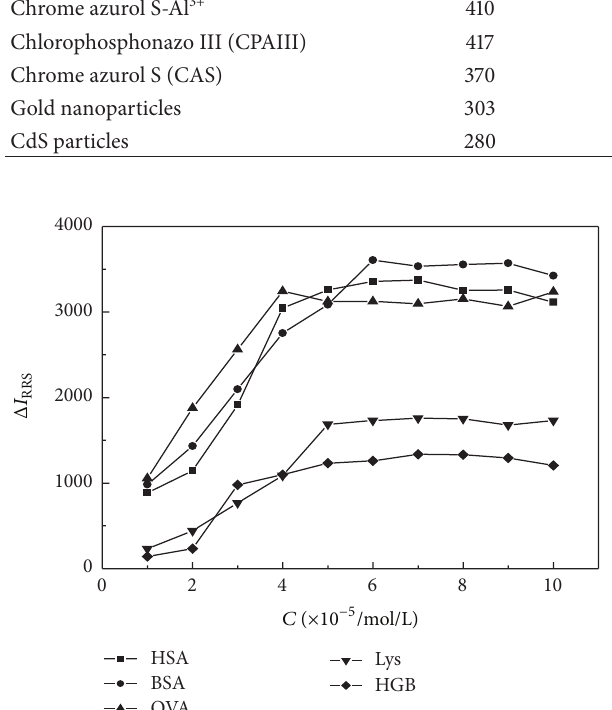
Figure 5: Effect of the concentration of CdS nanoparticles. HSA concentrations: 2.5 𝜇 g/mL; pH